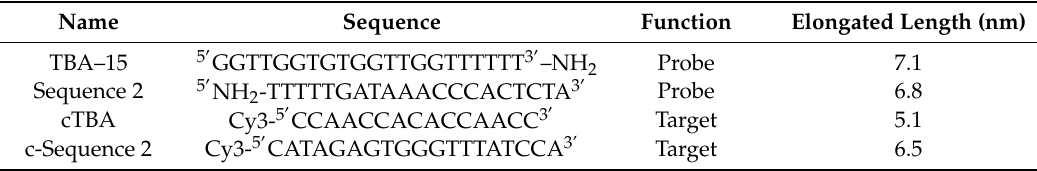
Table 1. Summary of the DNA sequence used in this